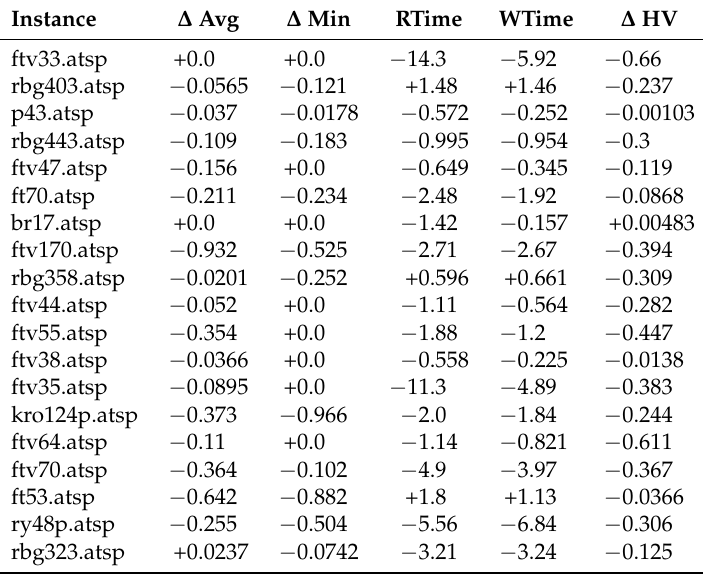
Table 2. Results from running Multistart and Multiverse Ant Colony optimization on TSPLIB